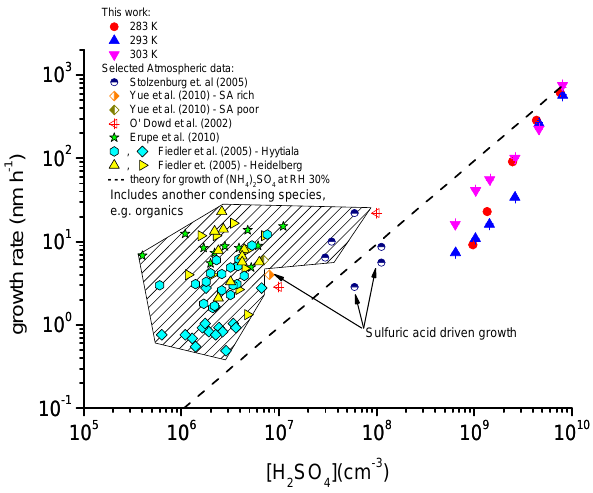
Figure 11. The experimental growth rates obtained under wet con- ditions (RH = 30%), with a residence time of 90s and three nucle- ation temperatures of 283, 293 and 303K. The atmospheric growth rates, obtained in Heidelberg and Hyytiälä during the QUEST project (Fiedler et al., 2005), data obtained in Atlanta during the ANARChE study (Stolzenburg et al., 2005), data from Beijing during the CAREBeijing-2008 campaign (Yue et al., 2010), data from Mace Head during the PARFORCE campaign (O’Dowd et al., 2002) and data from Kent, Ohio (Erupe et al., 2010) are depicted for comparison. The line presents the theoretical predictions of the growth of ammonium sulphate particles at an RH of